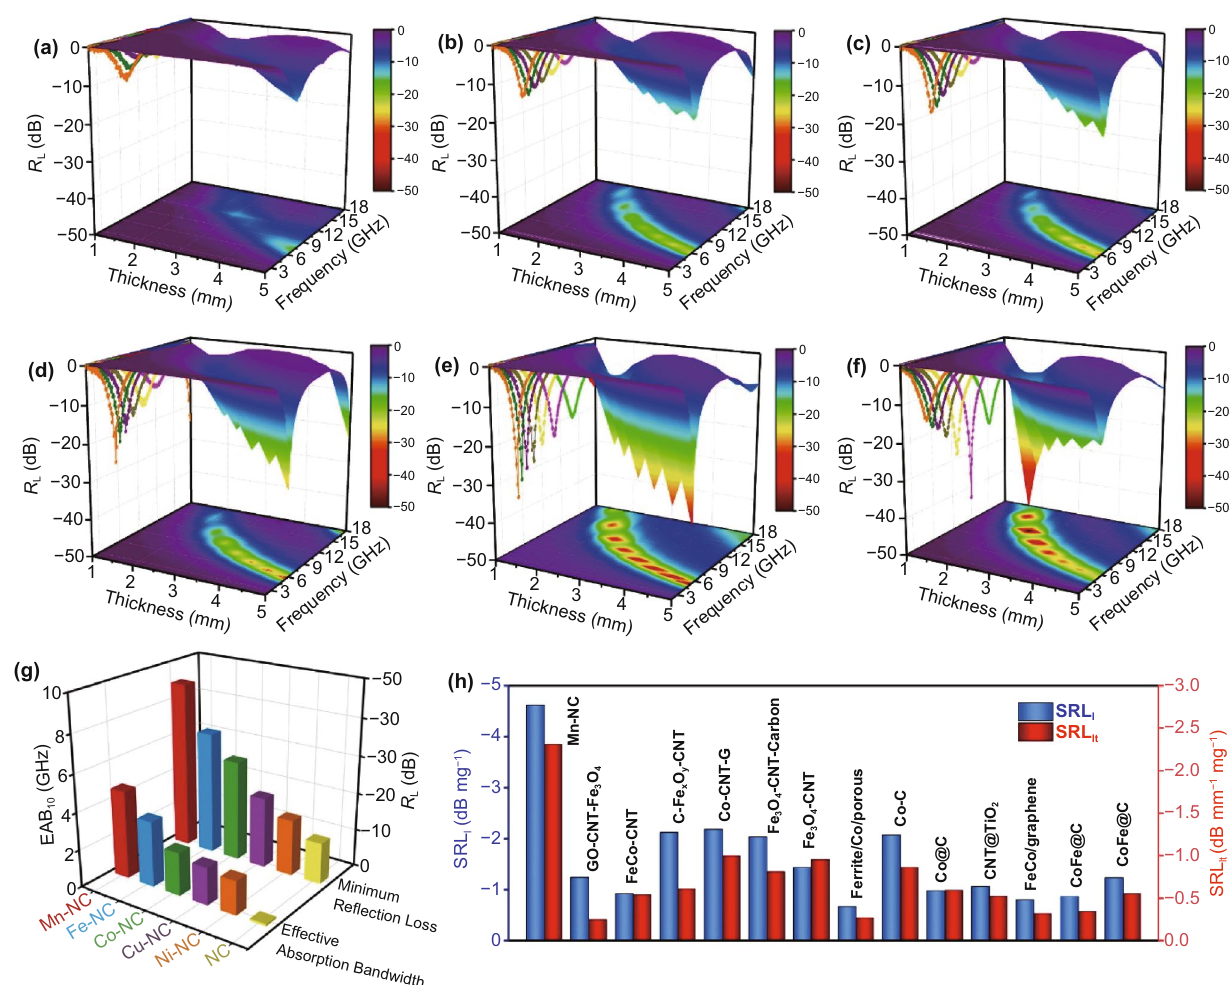
Fig. 7 Reflection loss curves and 3D plots of a 3D NC, b 3D Ni–NC, c 3D Cu–NC, d 3D Co–NC, e 3D Fe–NC, and f 3D Mn–NC. g Compari- son of R L, min and EAB 10 for 3D M–NCs and 3D NC. h SRL l and SRL lt values of 3D Mn–NC with the reported carbon-based